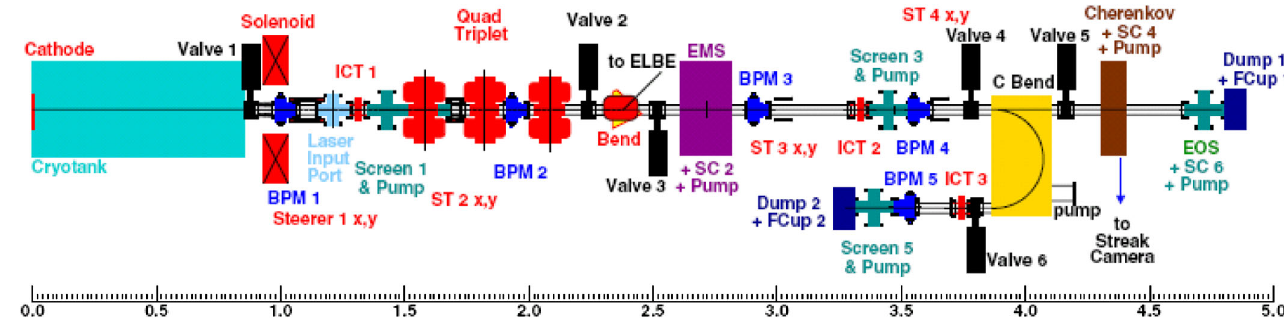
FIG. 7. (Color) General layout of the diagnostic beam line for the SRF gun project [12]. It consists of beam position monitors (BPM), integrated current transformers (ICT), profile monitors based on YAG screens, emittance measurement system (EMS), spectrometer dipole, Cherenkov radiator, electro-optical sampling system (EOS), Faraday cups (FCup), and the beam guide elements: quadruple triplet, steerer coils, and dipole magnet to the ELBE beam